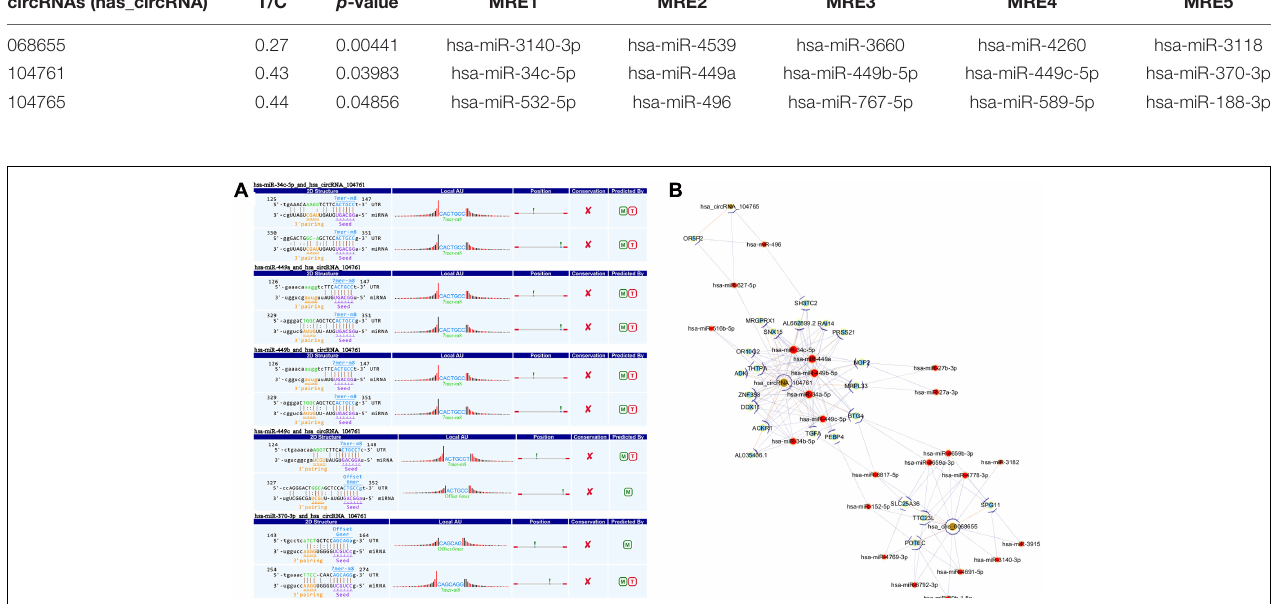
TABLE 2 | TargetScan and miRanda predicted the interaction between circRNA and microRNA. circRNAs (has_circRNA)